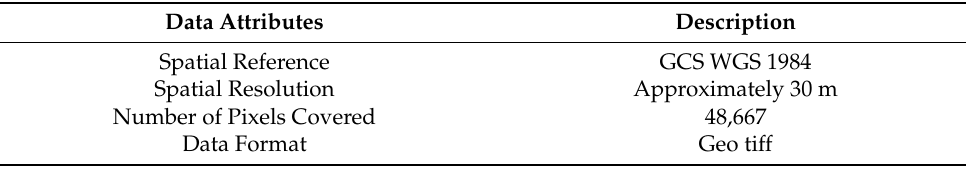
Table 1. Spatial Attributes of Manila